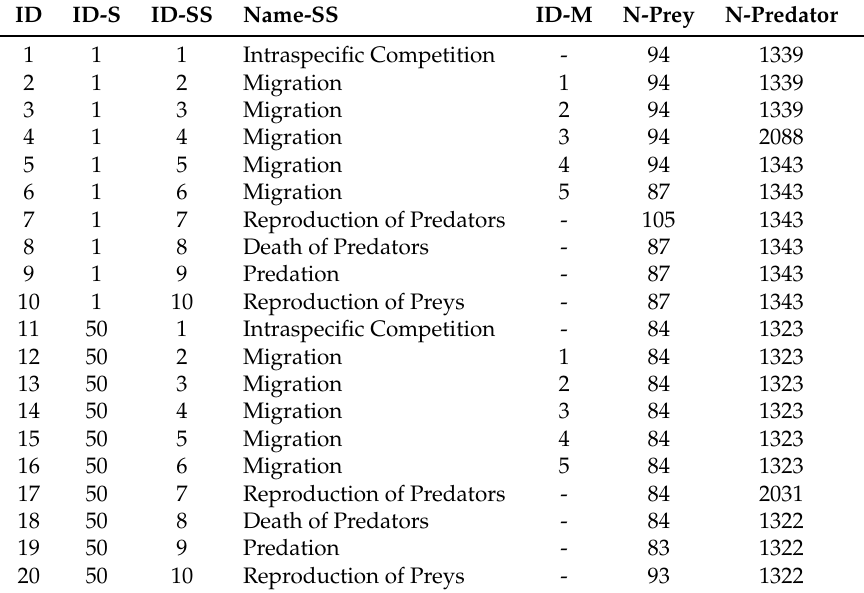
Table 5. Simulation carried out without using agents—Case B.